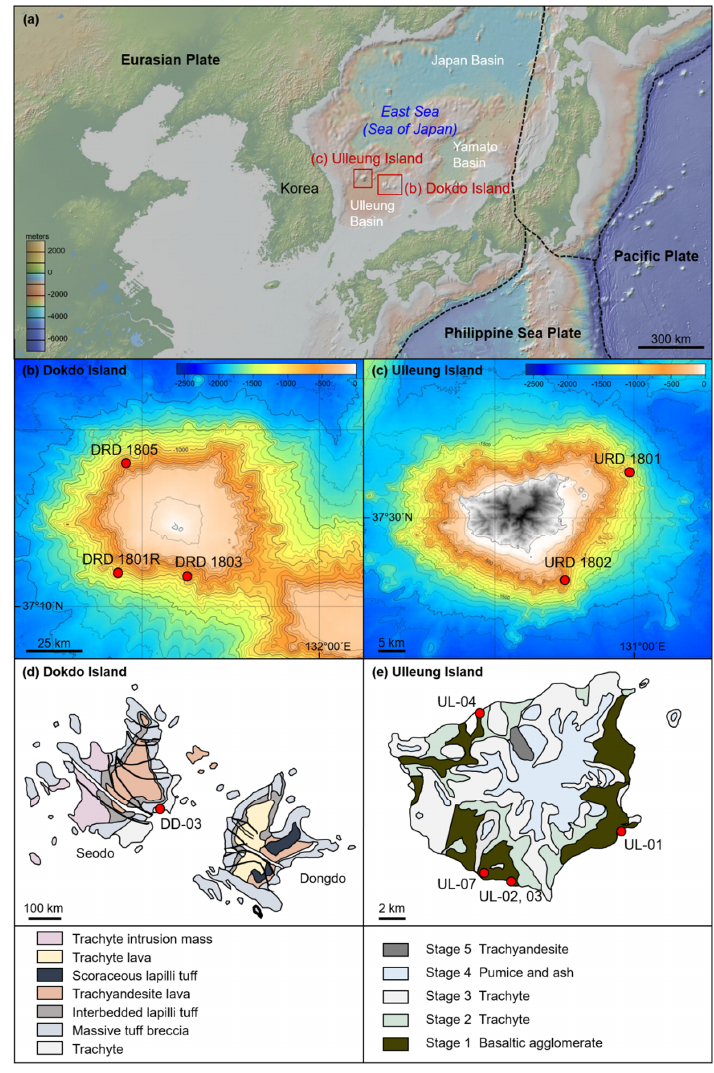
Figure 1. ( a ) Geological map of the Dokdo and Ulleung islands (DUI) with the distribution of adjacent plates (GeoMapApp 3.6.10). Contour maps of ( b ) Dokdo and ( c ) Ulleung generated using SURFER software. Contour interval is 100m. ( d , e ) Distribution of Late Cenozoic volcanic rocks from DUI [2]. ( b , c ) Submarine and ( d , e ) terrestrial sampling locations marked on map with solid red circles.